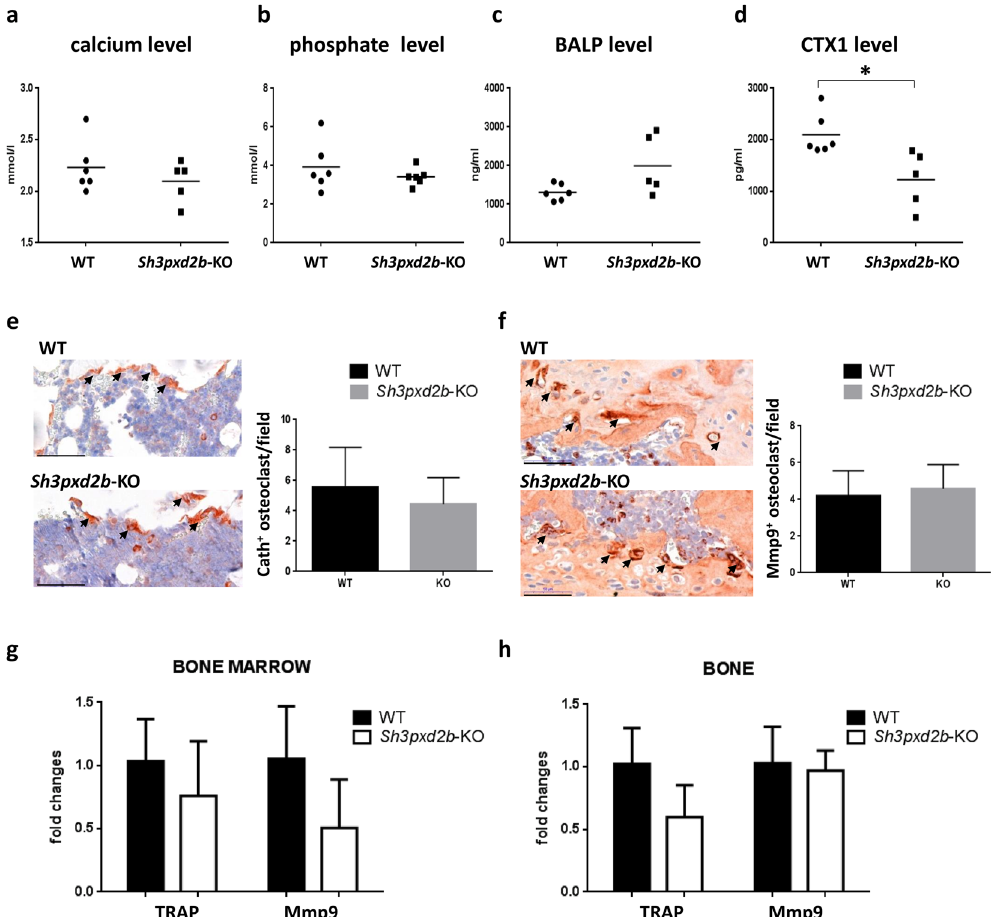
Figure 4. Examination of osteoclast markers. Measurements of the serum levels of calcium ( a ), phosphate ( b ), bone-specific alkaline-phosphatase (BALP) ( c ) and C-terminal telopeptide (CTX1) ( d ). The data were analyzed using Student’s t-test and 5–6 mice were used per genotype. The data are expressed as the mean ± SEM. ( e ) cathepsin-K-positive and ( f ) Mmp9-positive multinucleated osteoclast cells were quantified using IHC in the metaphyseal region of femurs from wild type and Sh3pxd2b -KO mice. Representative images of the stainings are shown. The number of osteoclasts/field in three wild type and three Sh3pxd2b -KO mice were analyzed, and the data are reported as the mean ± SEM. The scale bar represents 50 μ m. The osteoclast marker RT-PCR measurements were performed separately in femur BM ( g ) and hard bone tissue ( h ). The expression levels of the TRAP and Mmp9 bone resorption markers were measured. Three 7-month-old mice were used per genotype. The data are presented as the mean ± SEM, and the differences were analyzed by Student’s t-test. * p <